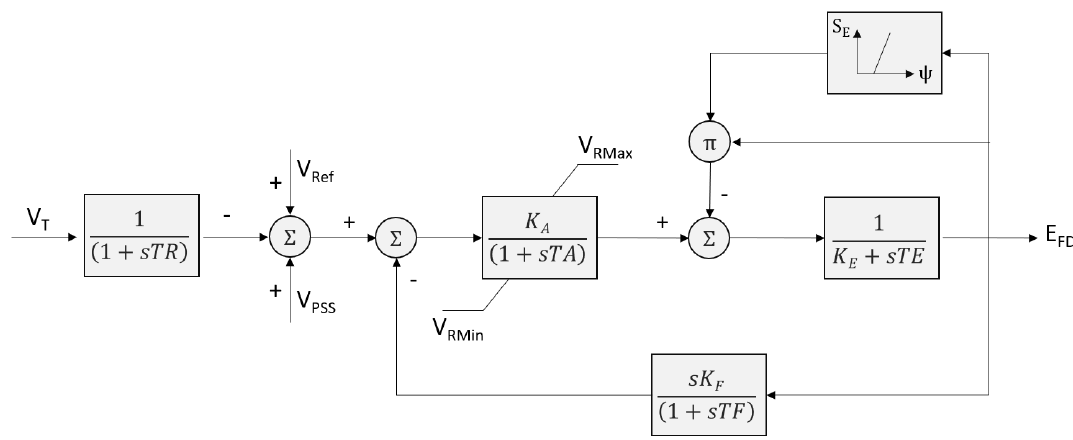
Figure A2. Automatic voltage regulator (AVR) IEEE T1.